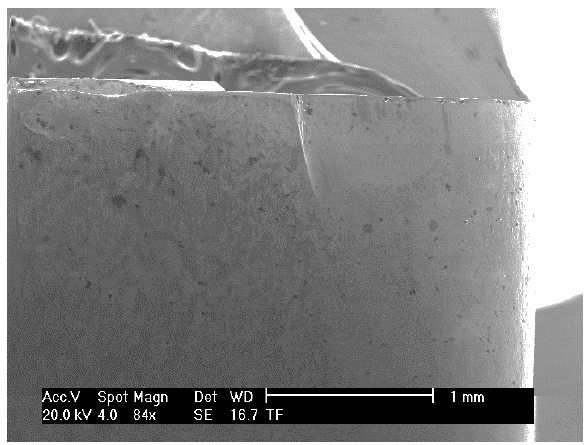
Figure 8. SEM images of the insert utilized in dry cutting.